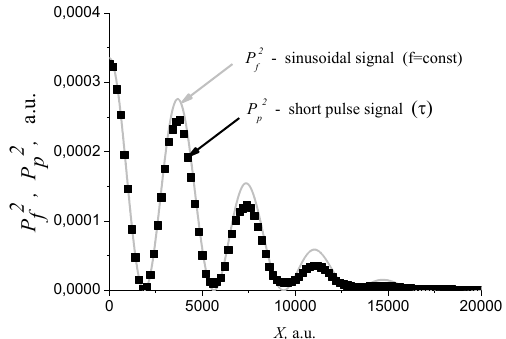
Fig. 3. Radiation patterns of CW (solid gray line) and short pulse (black dots) signals simulated for superposition of two Gaussian